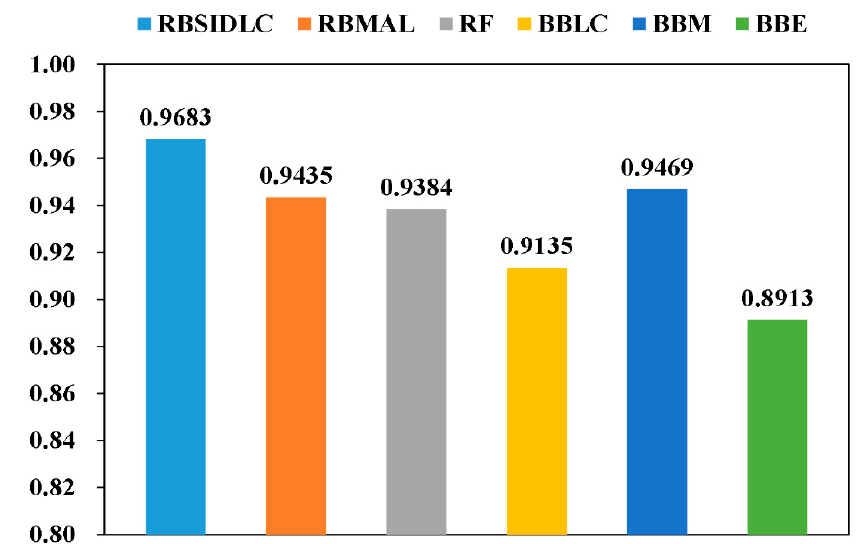
Figure 8. OAs of the preferred feature classification results with different algorithms.